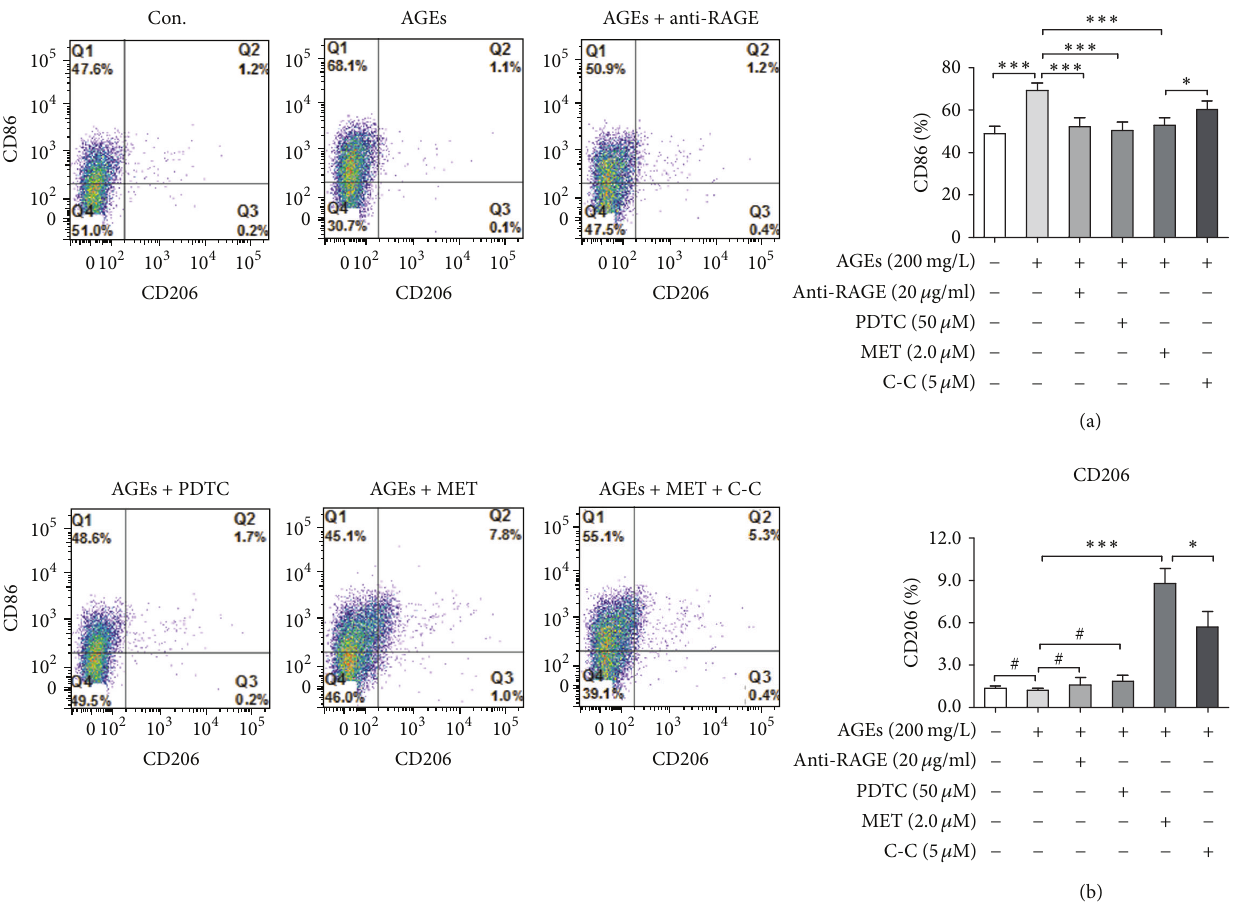
Figure 6: Metformin changes AGEs-induced surface markers expression on macrophages. BMDMs were divided into 6 groups: control, AGEs, AGEs + anti-RAGE, AGEs + PDTC, AGEs + MET, and AGEs + MET + C-C. In AGEs group, cells were cultured with AGEs at 200 mg/L for 24 h; in AGEs + anti-RAGE group, cells were pretreated with anti-RAGE neutralizing antibodies for 60 min followed by AGEs at 200 mg/L for 24 h; in AGEs + PDTC group, cells were pretreated with PDTC for 60 min followed by AGEs at 200 mg/L for 24 h; in AGEs + MET group, cells were pretreated with metformin at 2.0 𝜇 M for 60 min and then cultured with AGEs at 200 mg/L for 24 h; in AGEs + MET + C-C group, cells were pretreated with Compound C at 5 𝜇 M for 60 min, and then they were treated with metformin at 2.0 𝜇 M for 60 min followed by AGEs at 200 mg/L for 24 h; in control group, cells were cultured with BSA at 200 mg/L for the same amount of time. Single cell suspensions then were prepared. M1 surface marker CD86 and M2 surface marker CD206 were detected by flow cytometry analysis. Bar graphs represent the results (mean ± SD) of five independent experiments. One-way ANOVA was applied and all the overall ANOVA was significant. # 𝑝 > 0.05 ; ∗ 𝑝 < 0.05 ; and ∗∗∗ 𝑝 < 0.001 when compared between selected